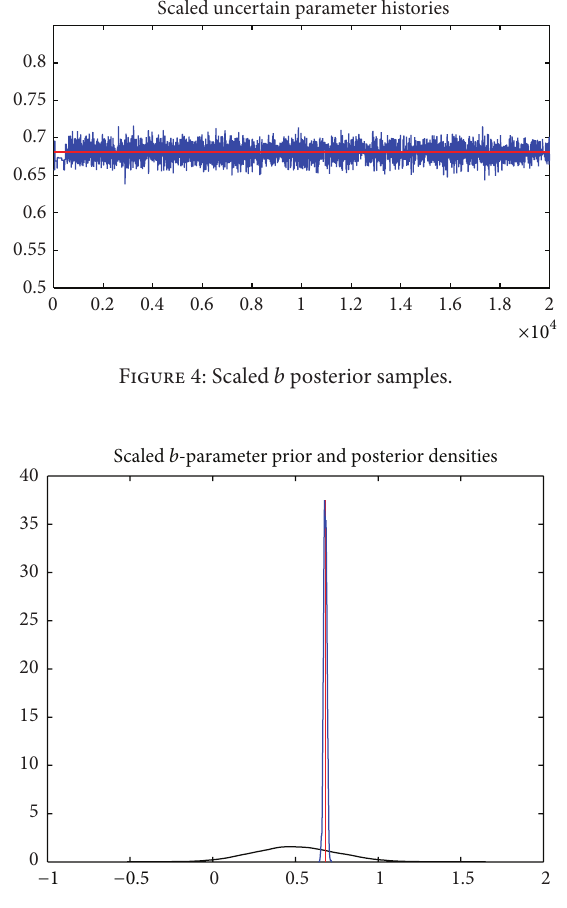
Figure 5: Estimated scaled 𝑏 posterior and prior